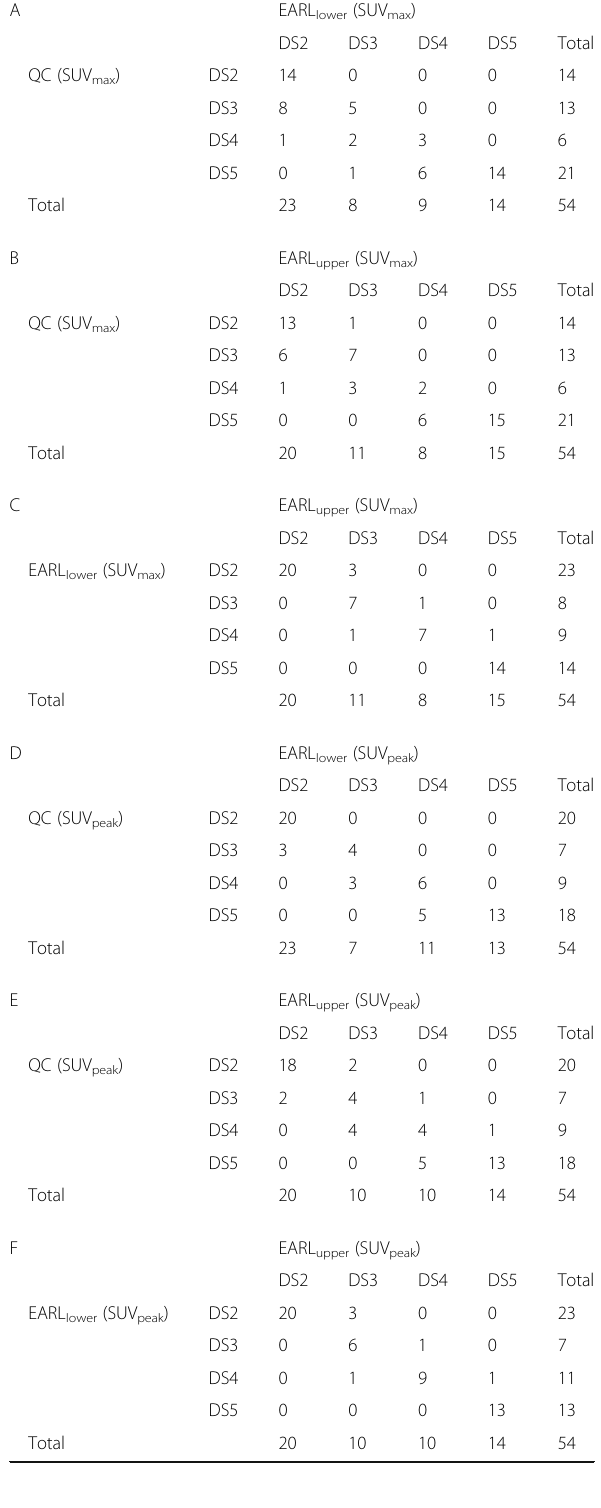
Table 1 Classifications of DS for the three different reconstruction methods using SUV max (A – C) and SUV peak (D –